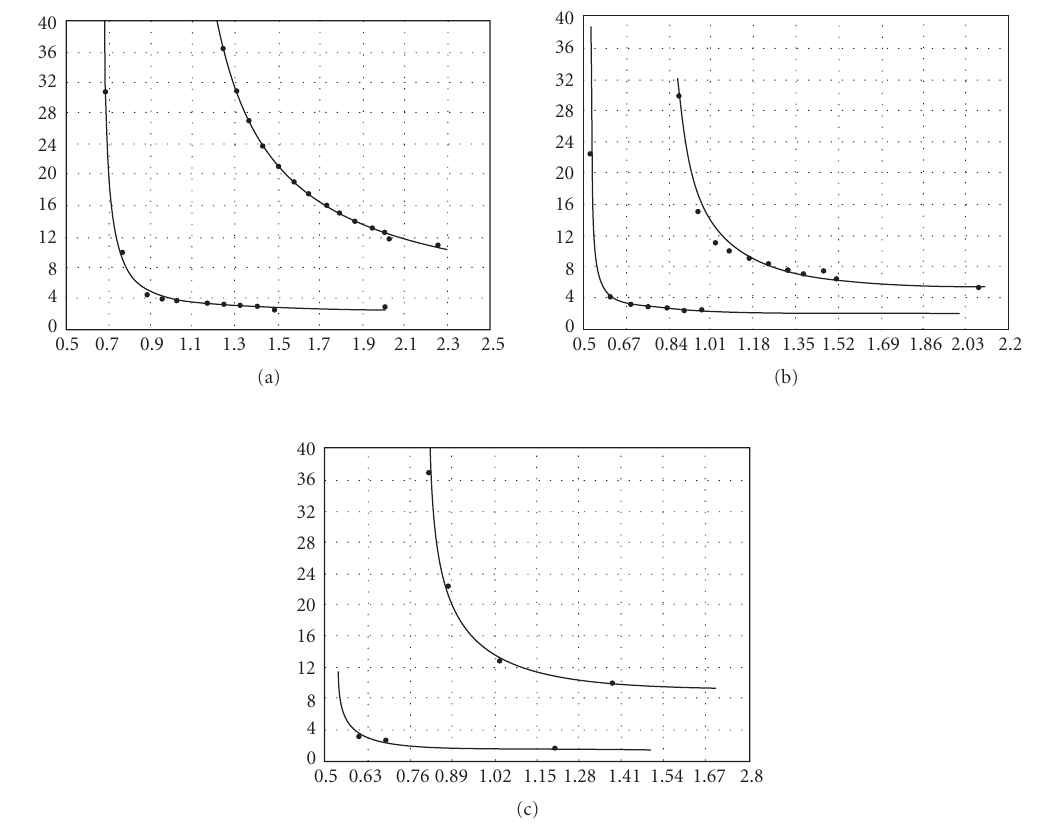
Figure 8: PV power-batteries energy curves at two di ff erent reliability levels (0 . 9,0 . 99) for (a) Serres, (b) Athens, and (c) Hania.